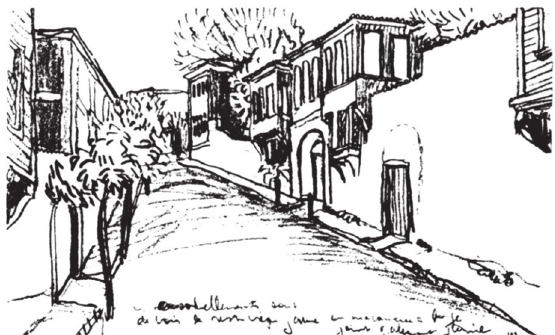
fig. 13. a sketch of Istanbul by Charles-Édouard jeanneret, 1911 (le Corbusier 1925: